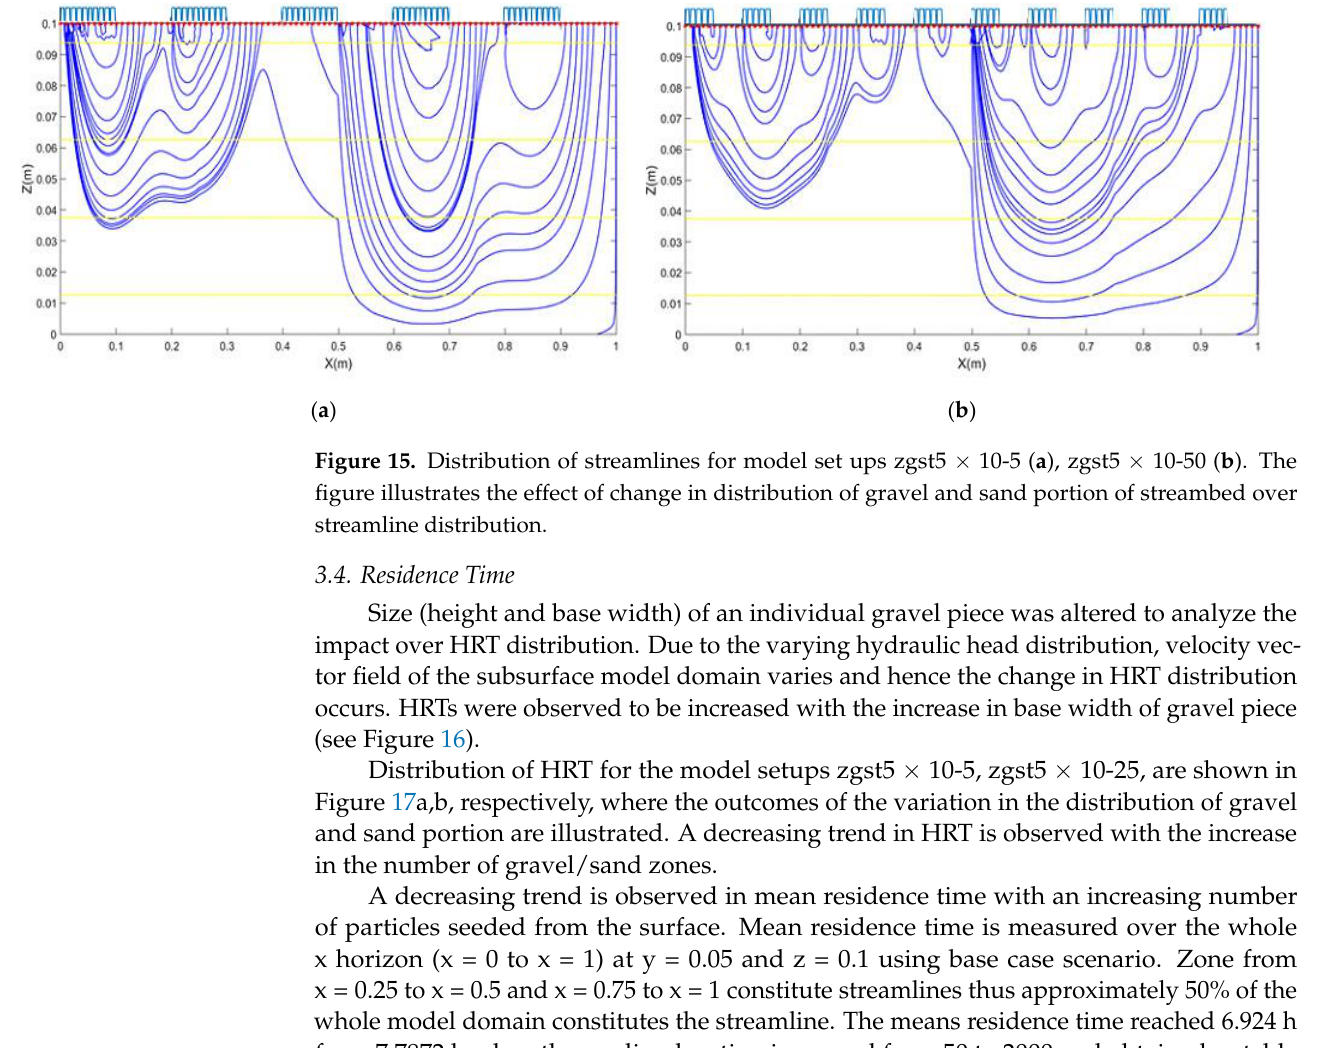
Figure 14. Distribution of streamlines for model set ups gpt8 × 10 ( a ) and gpt30 × 10 ( b ). Height variation in gravel pieces influences the number of streamlines generated from the same seeding locations. Gravel portions were shown using a rectangular block on the top of the figure distribution of streamlines for model set ups gpt5 × 25 ( c ), and gpt5 × 125 ( d ) resulted from the variation in base width of the gravel piece.